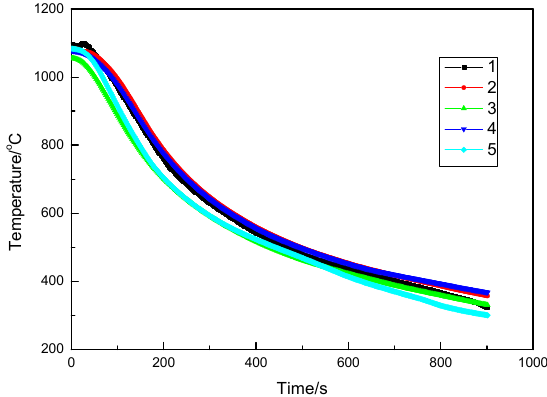
Figure 8. Temperature evolution during cooling at positions 1 to 5.